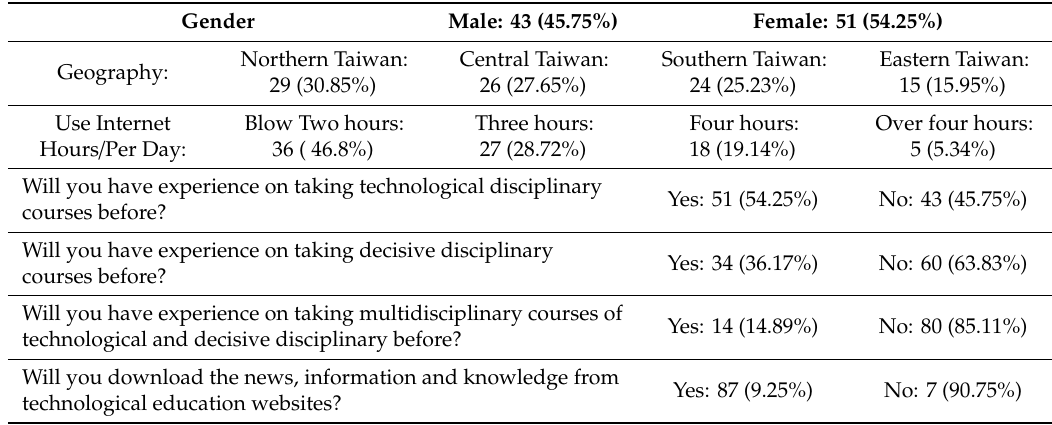
Table 2. The descriptive statistic of the factor analysis (FA) approach.